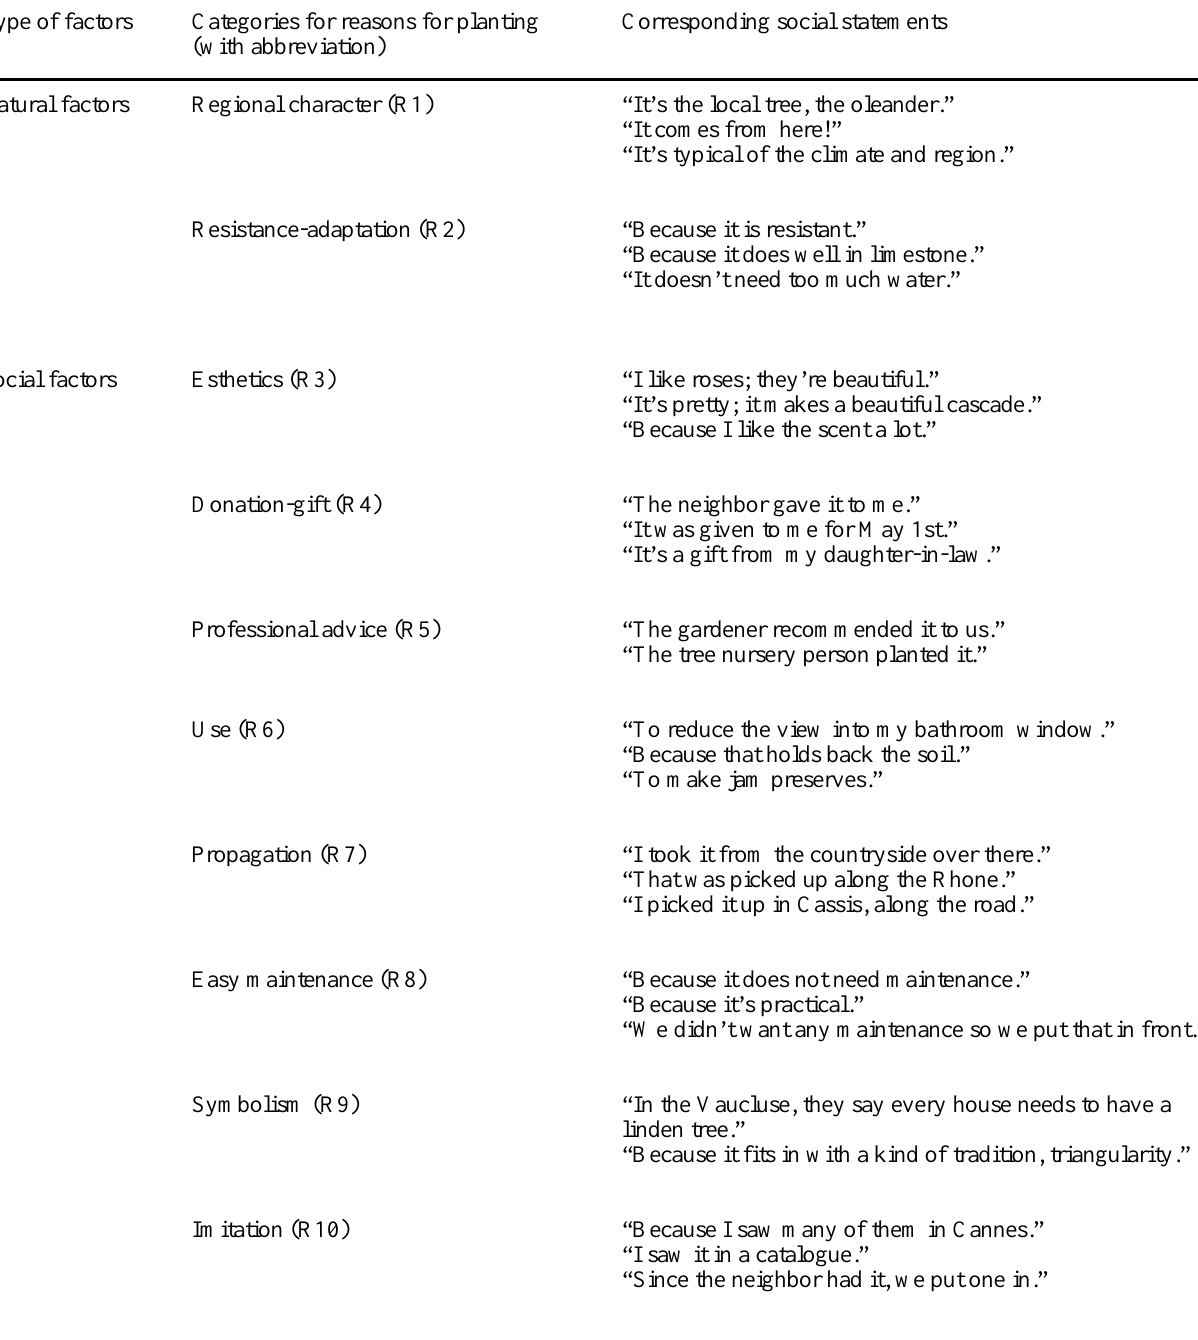
Table A-1. Categories for reasons for planting given by the gardeners and divided into natural and social